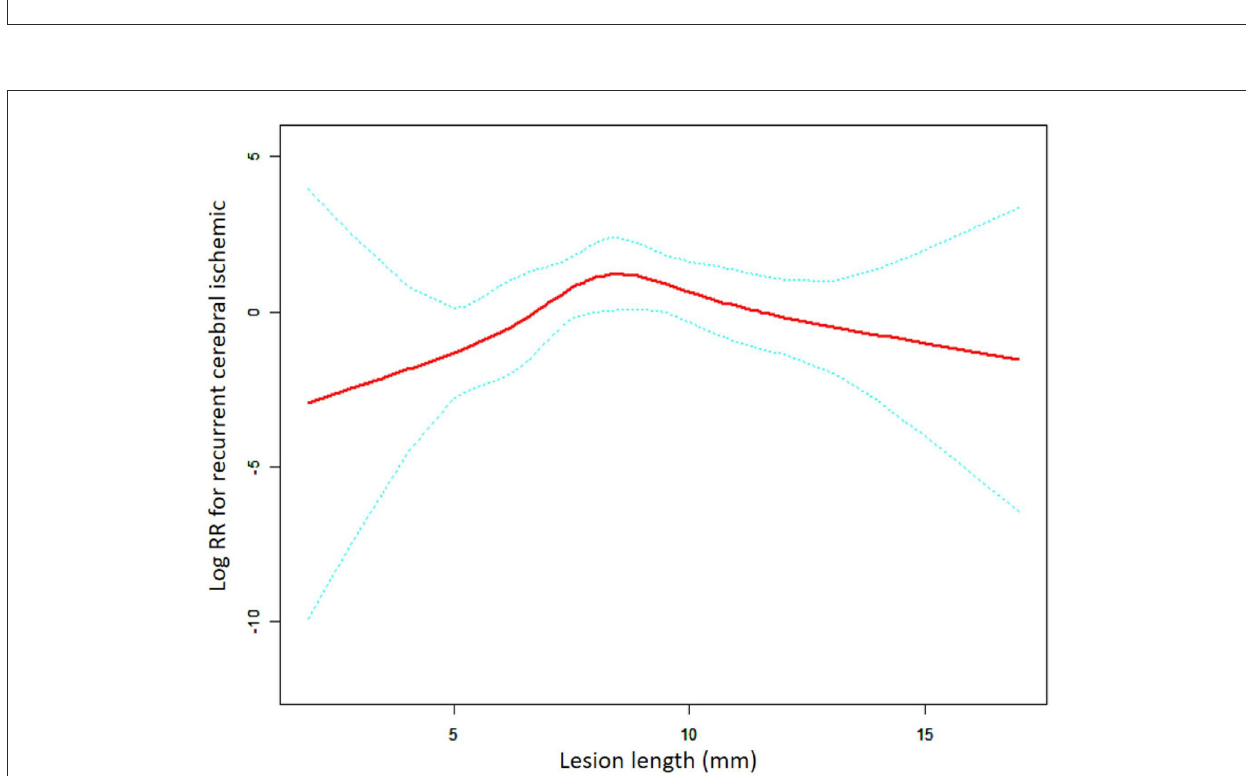
FIGURE3 A non-linear association between lesion length and recurrent cerebral ischemic in the SES group. The red solid line indicates the smooth curve fit between lesion length and RCI. The blue dotted line represents the 95% confidence interval of the fit (RR, relative